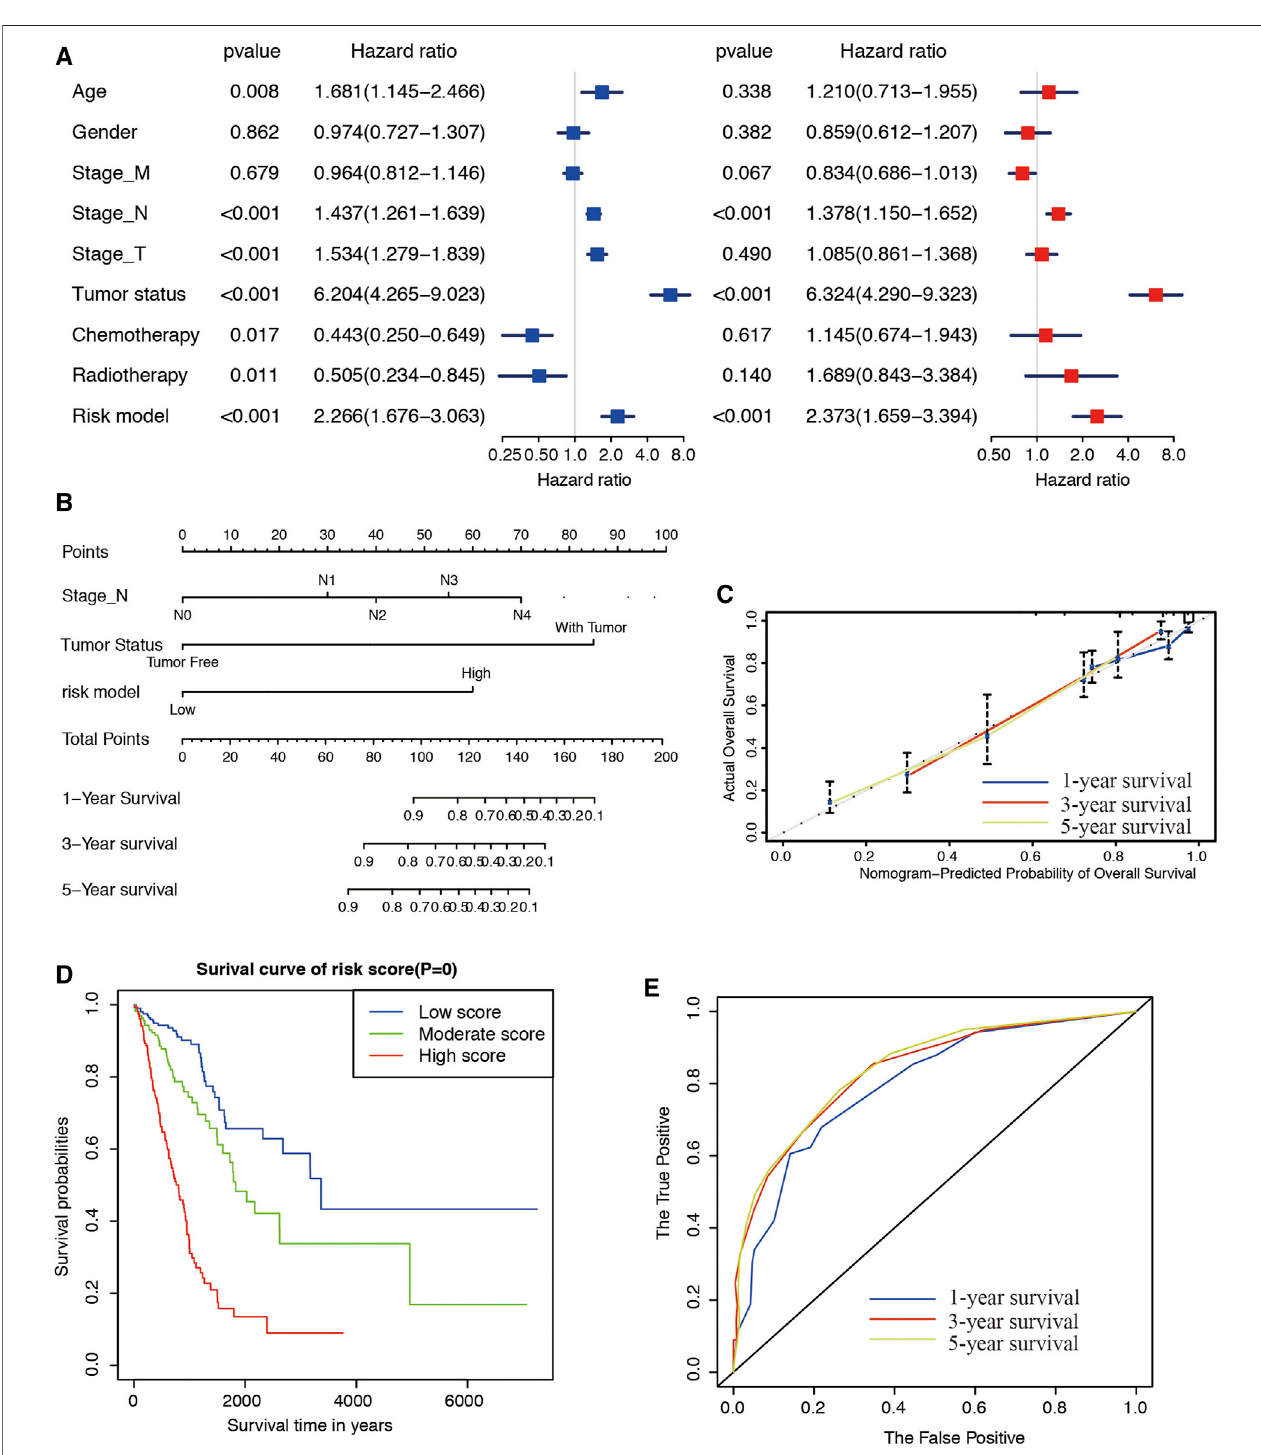
FIGURE 7 | Construction of a nomogram for survival prediction. (A) Univariate and multivariate Cox analysis of clinical characteristics and the risk model. (B) A nomogram for predicting OS in patients with LUAD. (C) Calibration plot of 1-, 3- and 5-years actual risk probability was displayed, suggesting moderate potential for predicting survival for patients of LUAD. (D) Kaplan-Meier curve analysis of the low, moderate, and high score groups. (E) Comparison of time-dependent ROC curves predicting 1-, 3-, and 5-years overall survival.